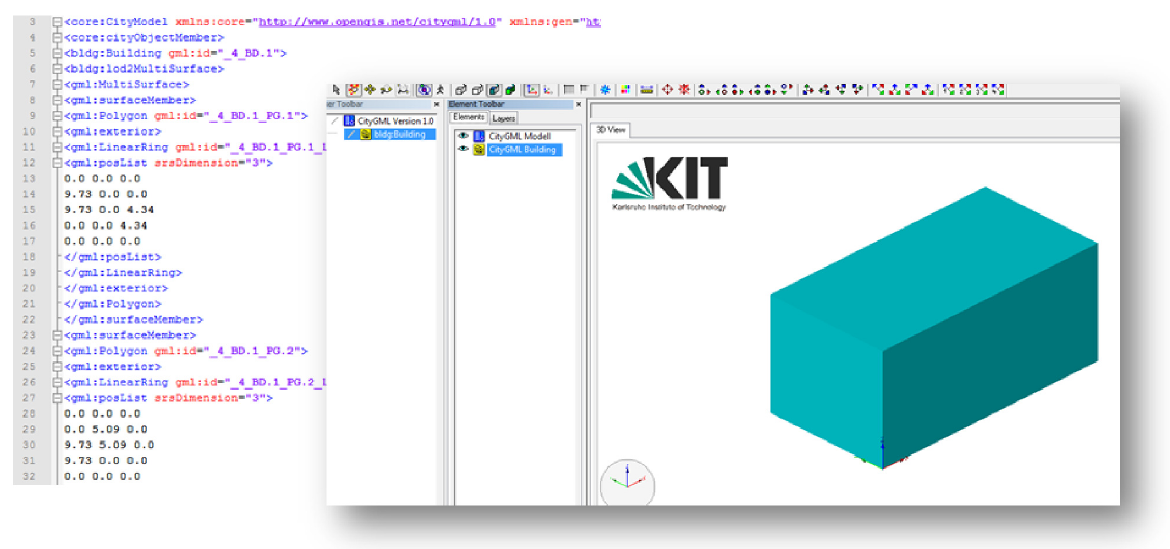
Figure 3: Representation of a building in CityGML done using Karlsruhe Institute of Technology’s IfcExplorer for CityGML (Karlsruhe Institute of Technology,